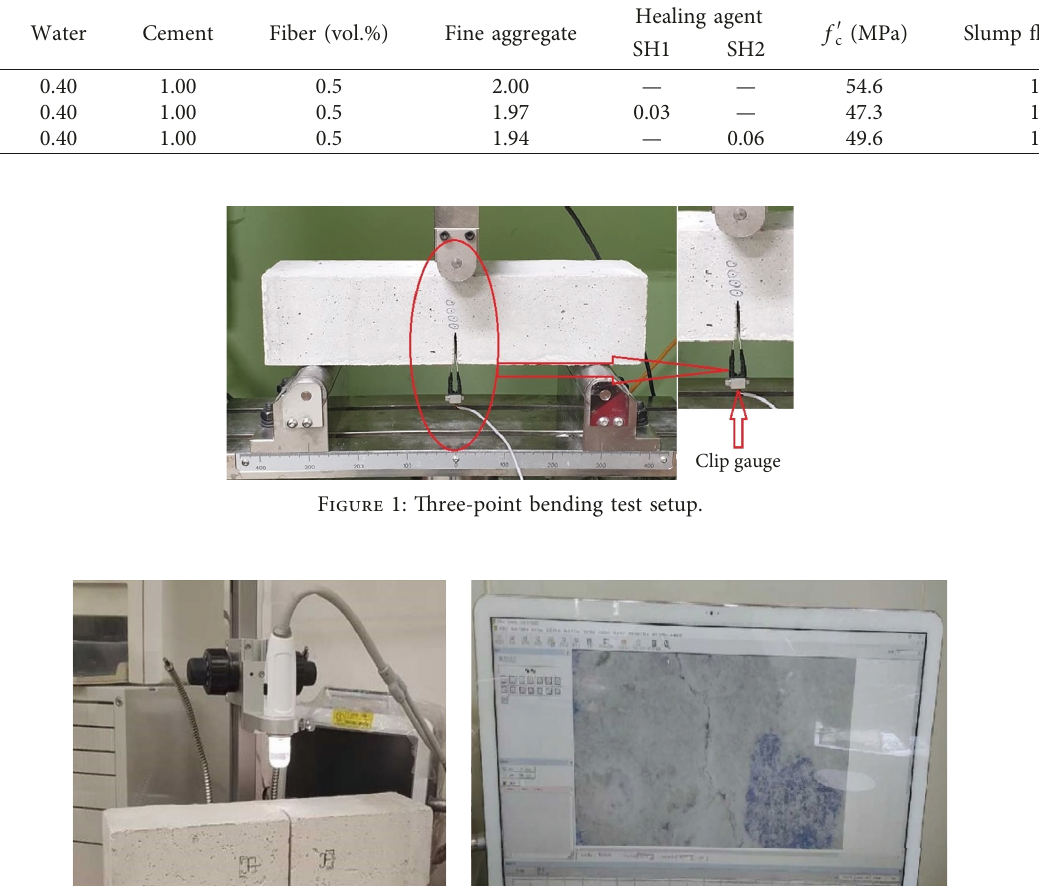
Table 1: Mix proportions for the three fiber-reinforced mortar mixtures.